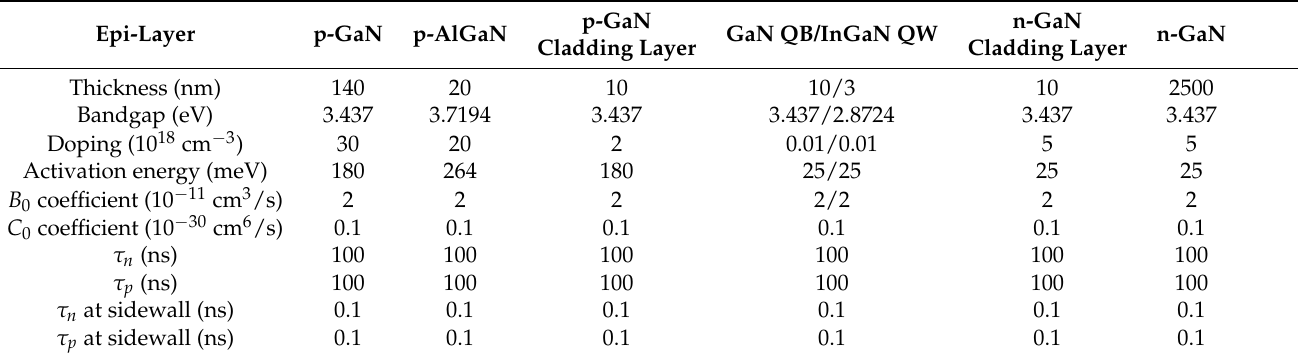
Table 1. Parameters of blue µ -LEDs.